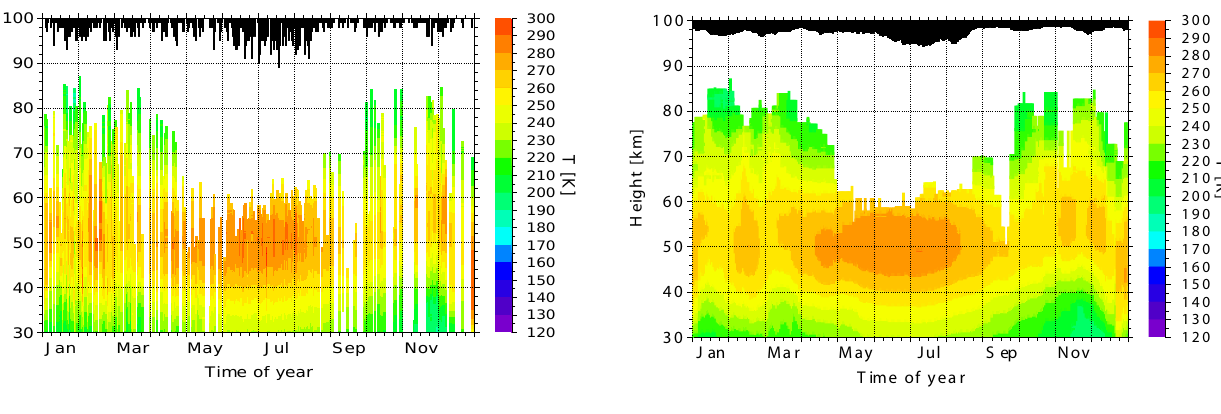
Fig. 3. Seasonal temperature variation during the years 1997–2005. Multiple measurements on the same day are averaged. The black bars give the number of measurements on each day (1km b = 1 mea- surement). The gaps in mid-May and at the end of December are caused by missing data due to unfavourable weather conditions.